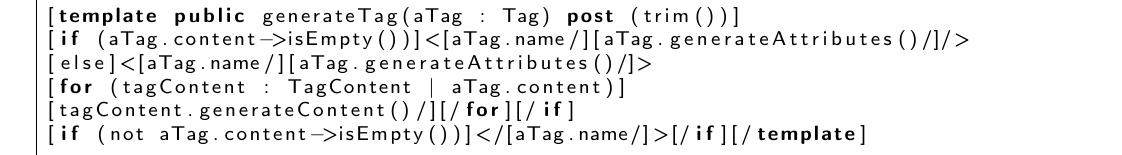
Figure 8. Template for generating XML tags in